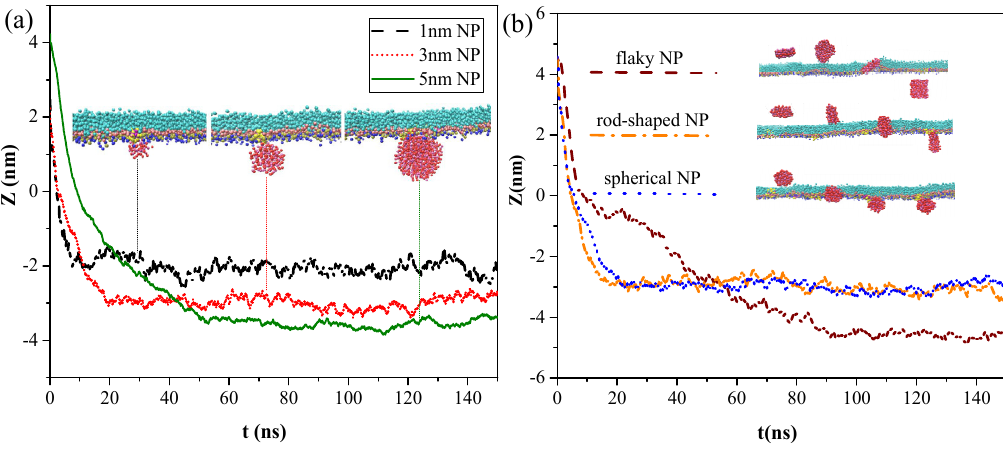
Figure 5. Snapshot of transmembrane and centroid-to-centroid distances of NPs with different ( a ) NP sizes and ( b ) NP shapes.